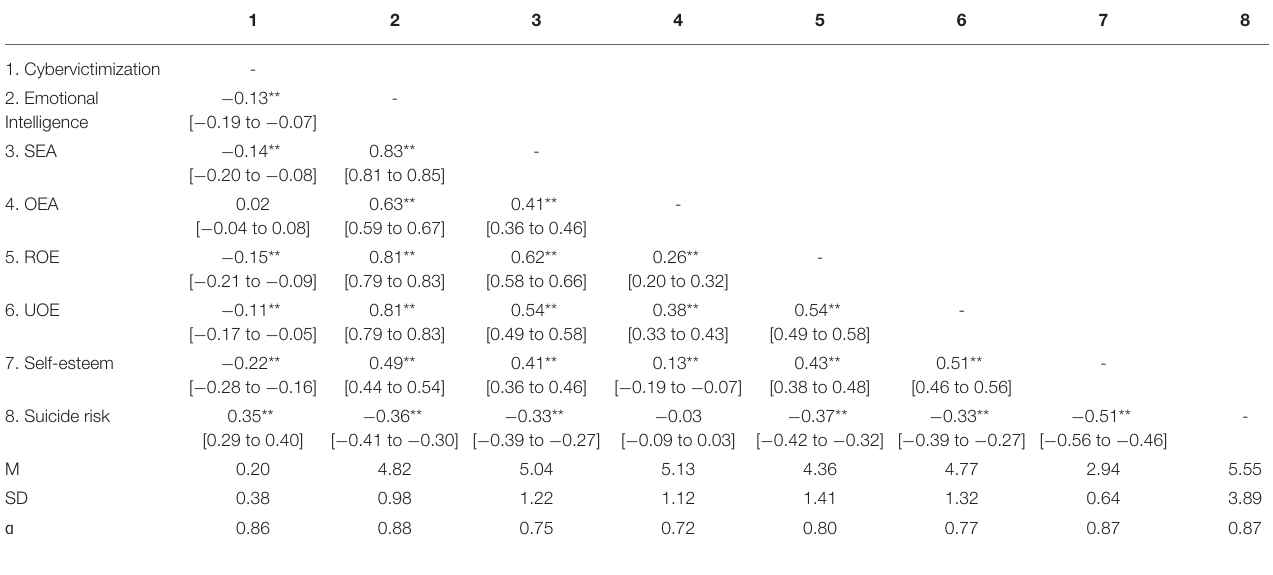
TABLE 1 | Descriptive statistics and intercorrelations among study variables.